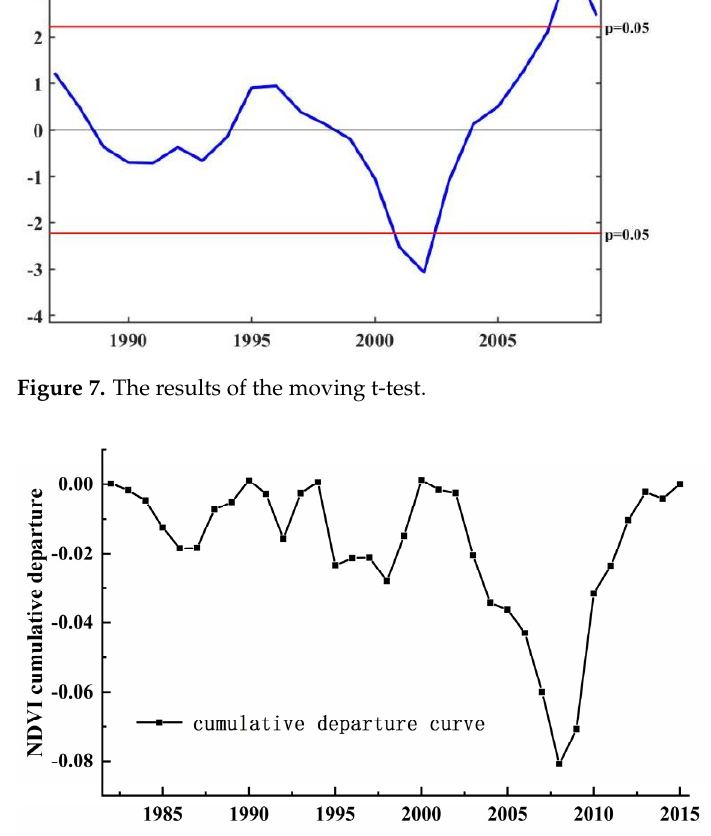
Table 5. q values of